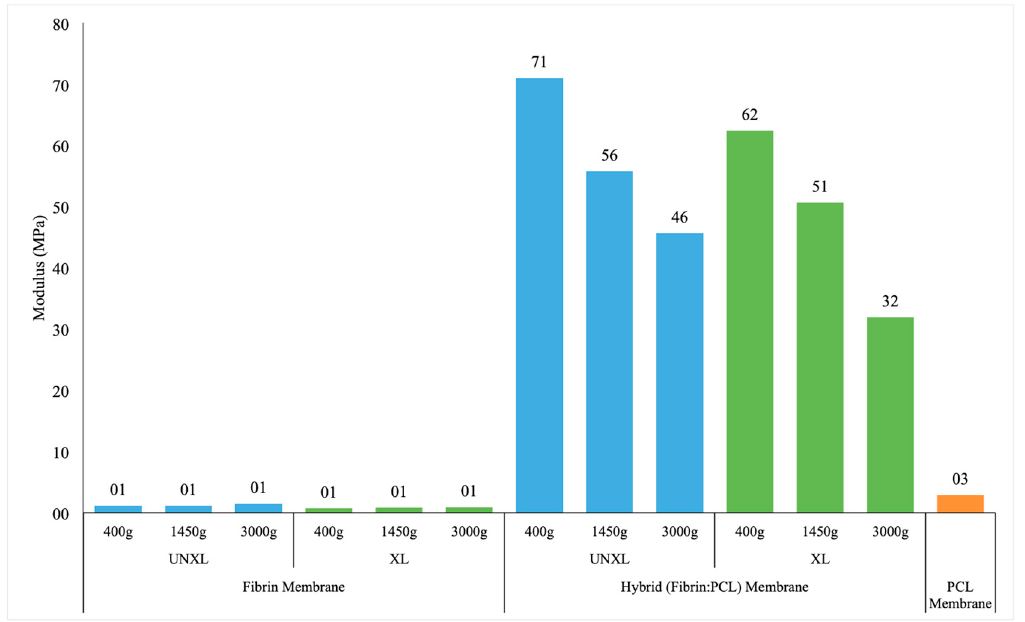
Figure 5. Elastic modulus of fibrin membrane, hybrid membrane and pure PCL membrane. Data shows extremely fragile fibrin matrices when compared the electrospun PCL membrane. Hybrid membrane shows improved stiffness compared to PCL indicating the additive effect of fibrin crosslinking on the electrospun PCL membrane . Key: UNXL: uncrosslinked; XL: crosslinked.